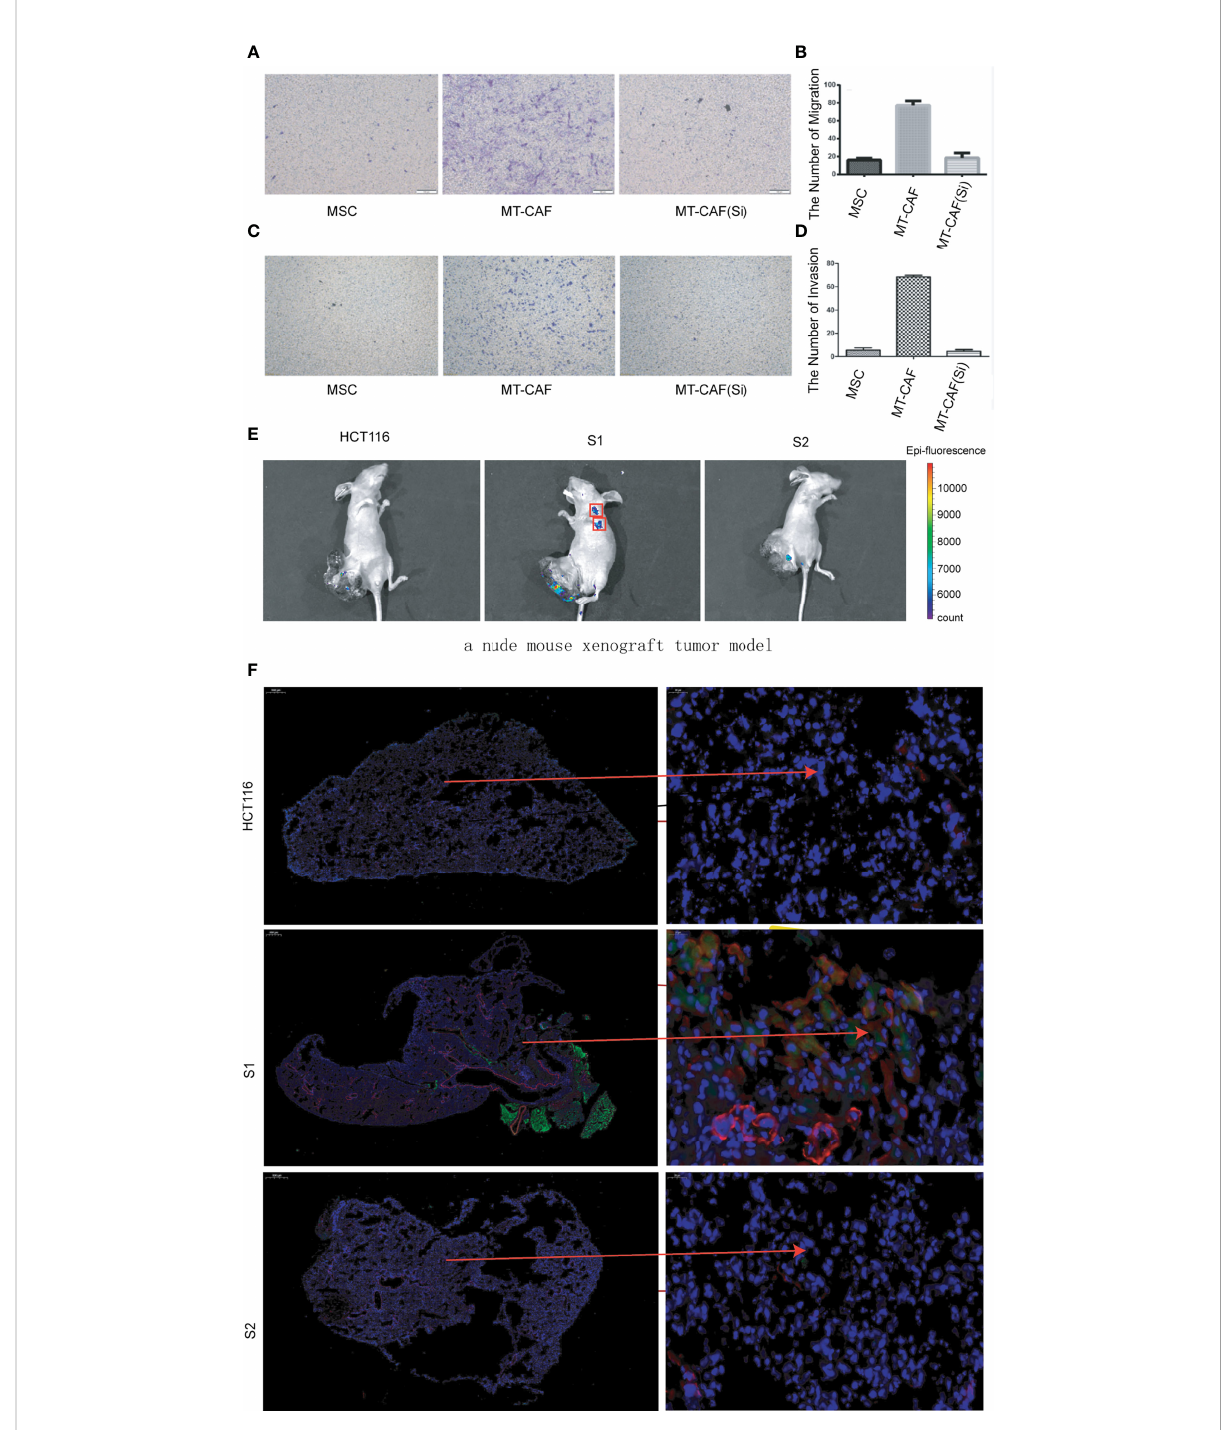
FIGURE 3 Knockdown ICAM-1 in MTCAFs attenuates their migration and homing abilities. (A, B) Transwell migration assays to evaluate the MTCAF migratory capacity were performed and are represented. The left side shows a representative microscopic image of the crystal violet staining. The right shows the quantitative results. (C, D) Transwell migration assays to evaluate the MTCAF invasion capacity were also performed and are represented. The left side shows a representative microscopic image of the crystal violet staining. The right shows the quantitative results. (E) In vivo fl uorescence image showing the effect of combined MSC transplantation on tumor metastasis. Three groups of mice were transplanted with HCT-116 5 × 10 6 cells, HCT-116 5 × 10 6 cells + MSC 1 × 10 6 cells, and HCT-116 5 × 10 6 cells + MSC with ICAM1 knocking down 1 × 10 6 cells. The MSC cell lines carried GFP. (F) MTCAF density was measured using immuno fl uorescence staining in mice lung tissues by staining a - SMA and GFP transfected in